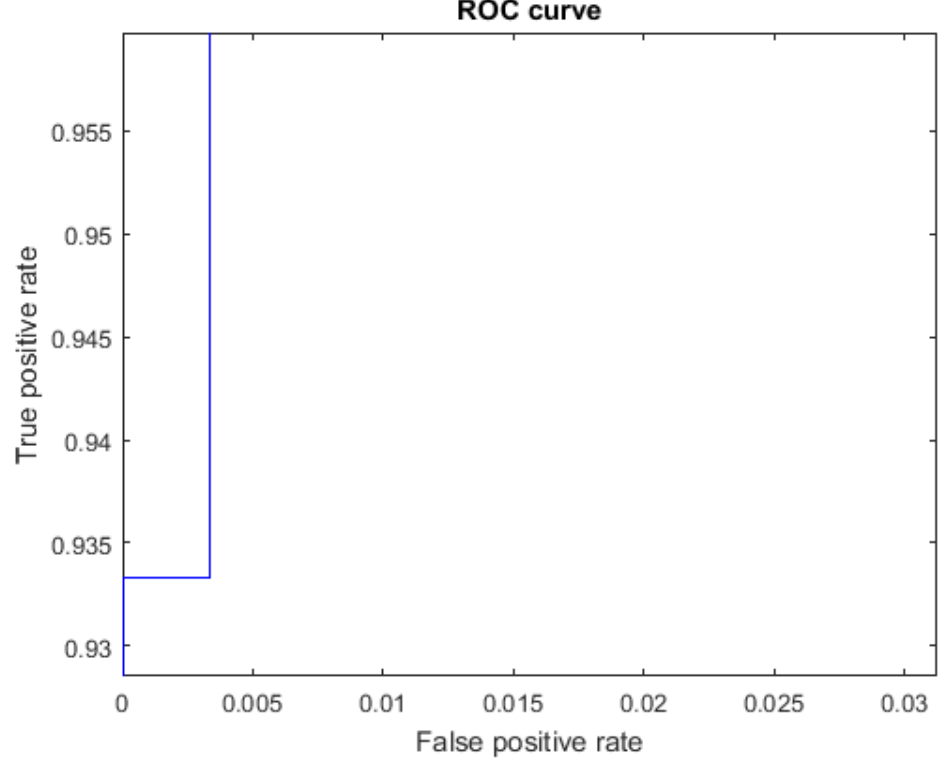
Figure 17. ROC curve for the letter V using Cartesian features, AUC = 0.9998.